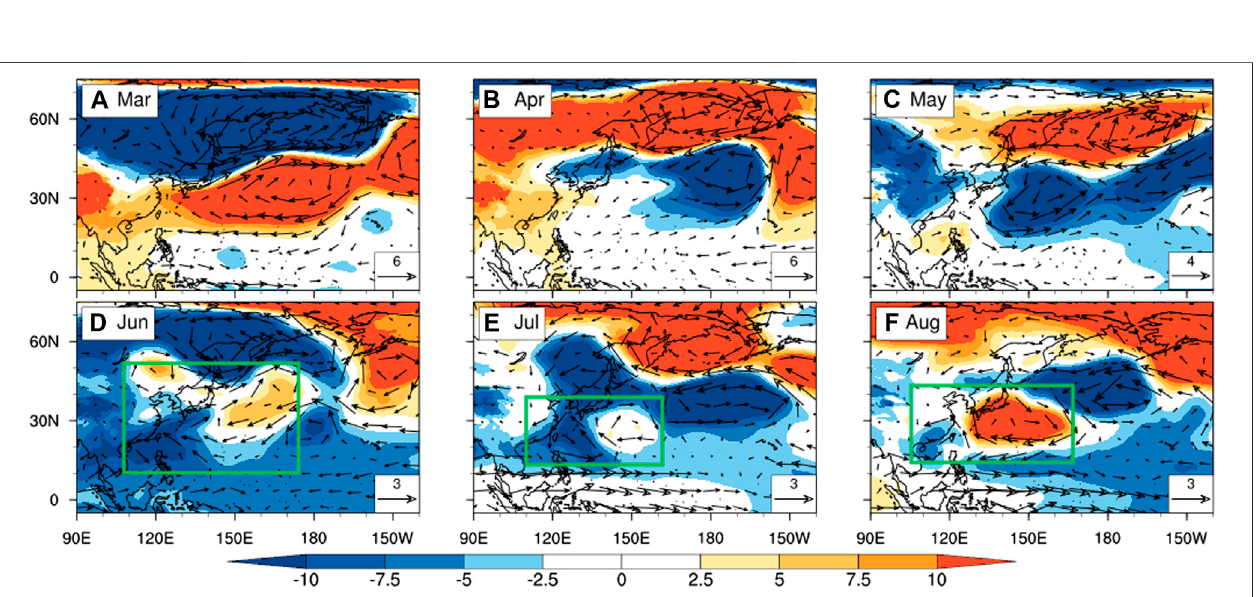
FIGURE10| Height-latitudecrosssectionsofthecompositedifferenceofanomalousmeridionalcirculation( A :123 – 128 ° E; B :110 – 120 ° E;unit:m s − 1 )betweenthe extreme high years and lowyears of (A) SLP TCP,4 in July, August, and September and (B) SST SWA,34 inJune, July, and August. Verticalvelocityis multiplied by 100. The pink (purple) dash rectangle speci fi es the anomalous downdraft (updraft) in the 5 – 13 ° N (10 – 25 ° N) band in positive SLP TCP,4 (SST SWA,34 ).